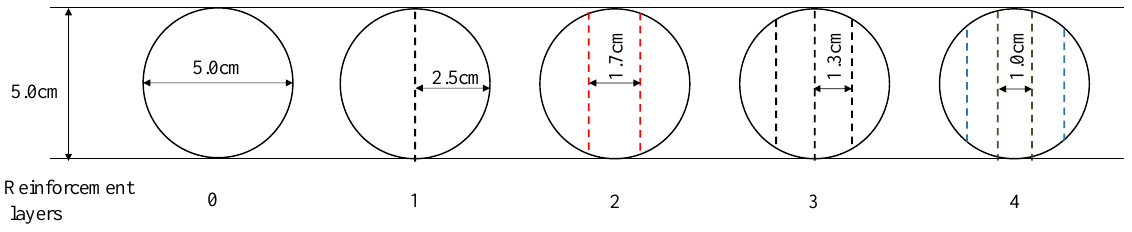
Figure 4. The layout of reinforcement.